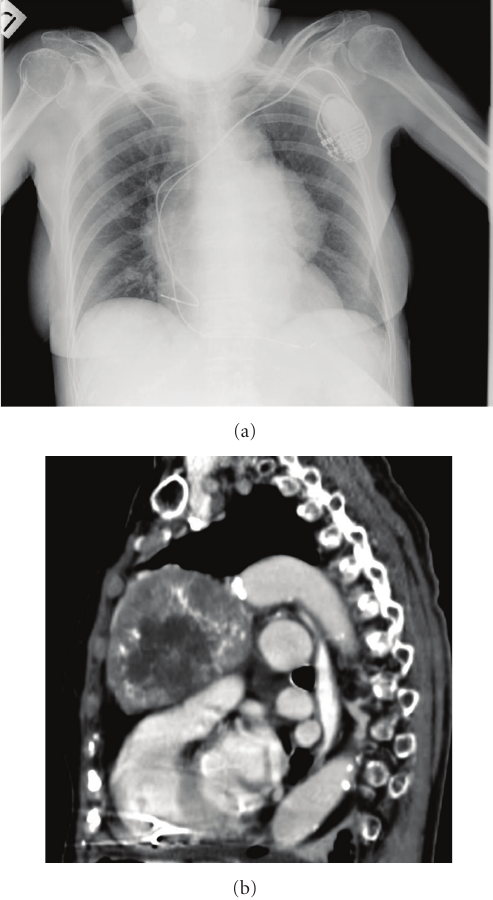
Figure 1: (a) Chest X-ray shows enlargement of the mediastinum. (b) Chest computed tomography image demonstrates a large inhomogeneous mass with calcifications in the anterior mediastinal compartment. The tumor is in close relationship with the ascending aorta and the common trunk of the pulmonary artery, with apparent preservation of a cleavage